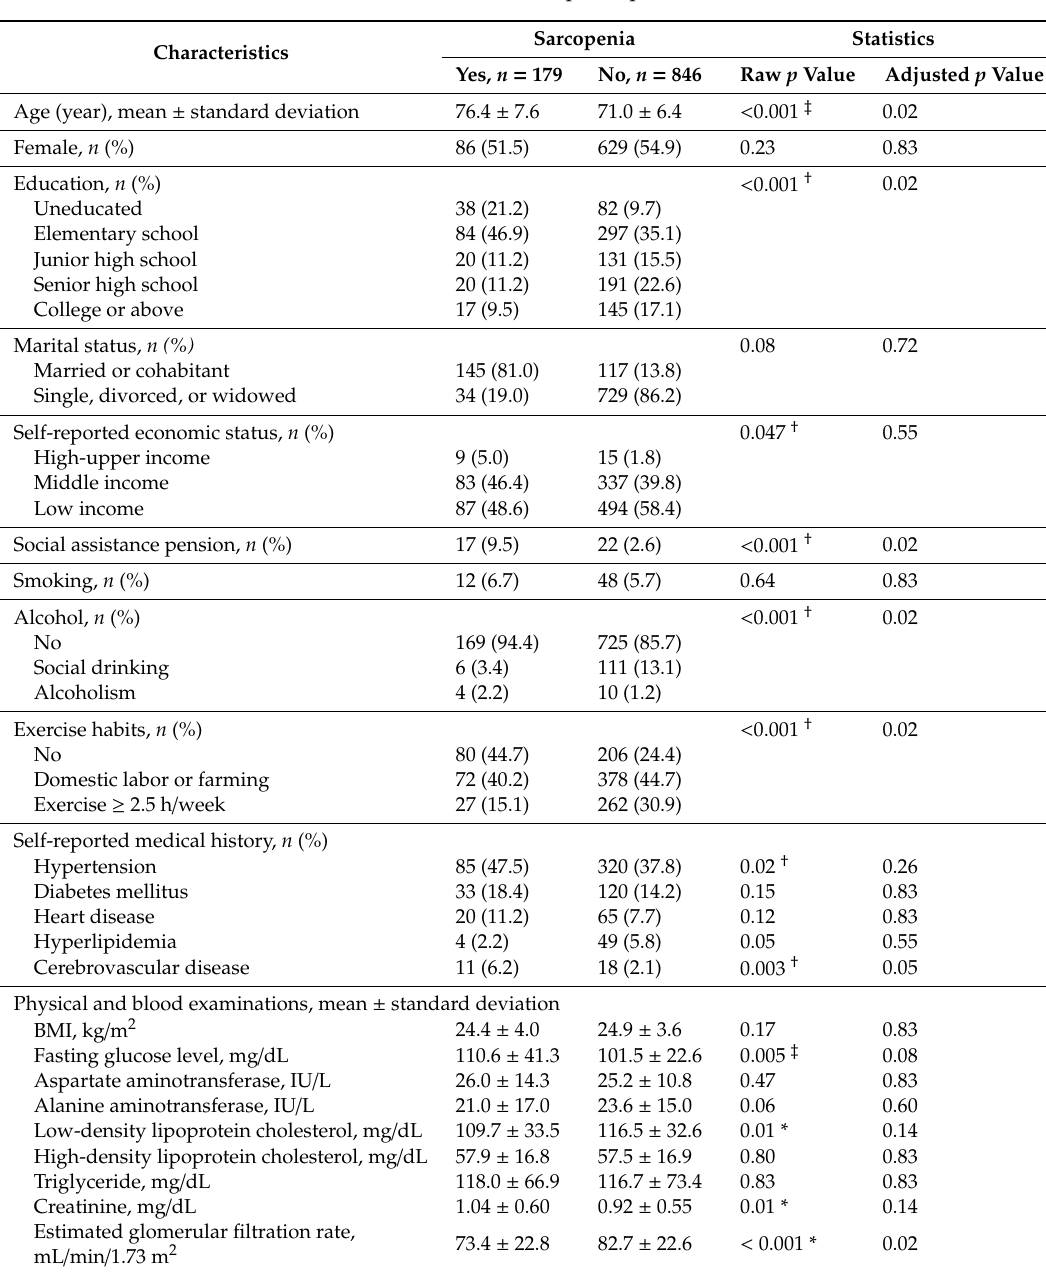
Table 1. Characteristics of the participants ( n =